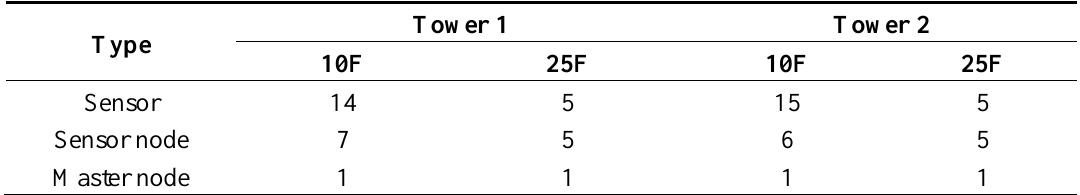
Table 1. Number of sensors, sensor nodes, and master nodes deployed for measurement of column